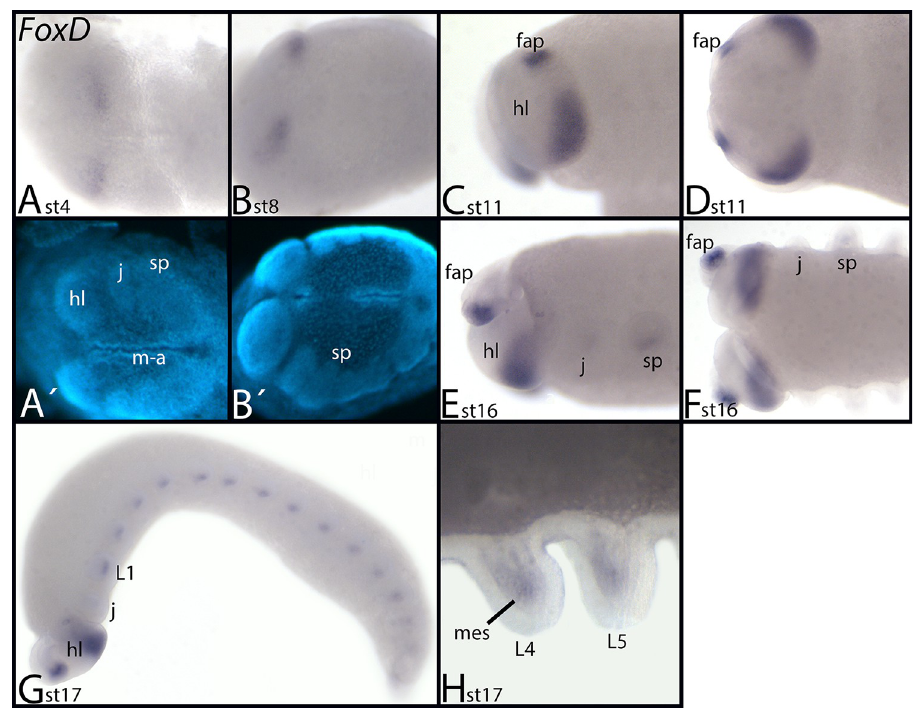
Fig 7. Expression of Euperipatoides FoxD . In all panels, anterior is to the left. Panels A, B, and F, ventral view; panels C, E and G, lateral view, panel D, view of the head. A´/B´ represent DAPI staining of the embryos shown in A/B. Abbreviations in Table